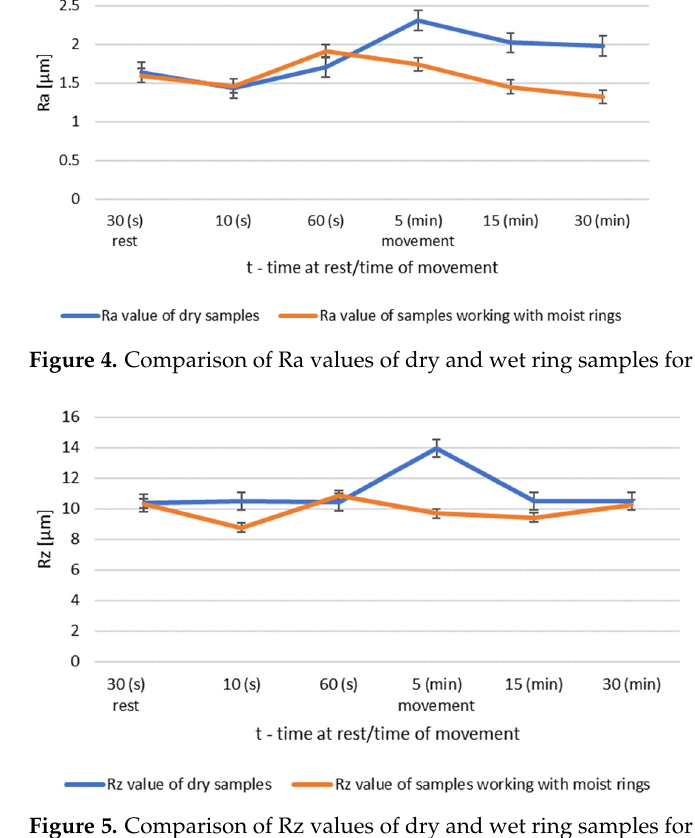
Figure 5. Comparison of Rz values of dry and wet ring samples for roughness group I.